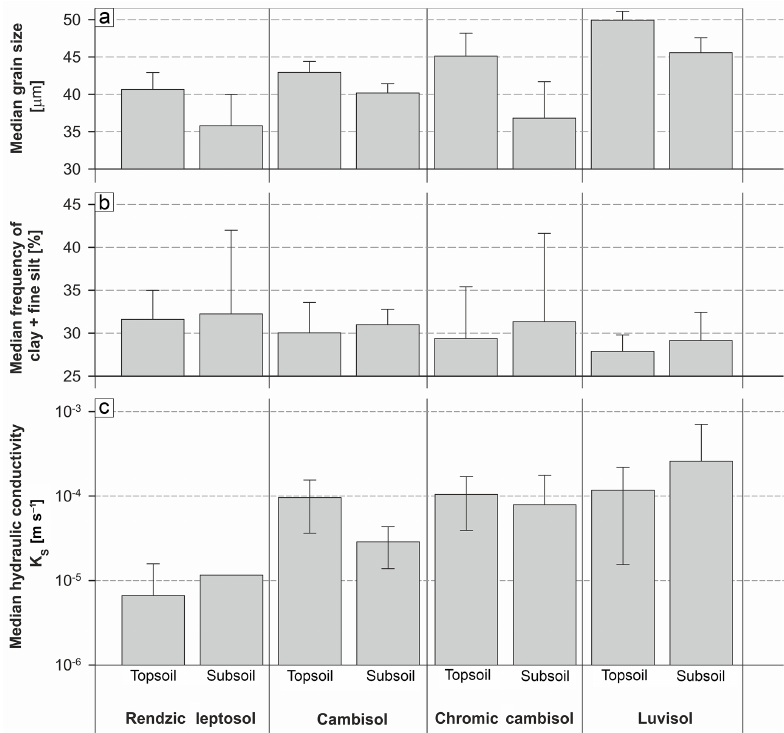
Figure 3. Physical properties of topsoils/subsoils and parent rocks of the four major soil groups. Median grain size decrease (a) and the frequencies of the fine grain size fractions (clay + fine silt) increase towards the subsoil (b) , respectively. (c) : median soil hydraulic con- ductivities of soil groups showing higher median soil hydraulic conductivity in Chromic Cambisols and Luvisols compared to the Rendzic Leptosols and Cambisols and general decreases in hydraulic conductivity towards the subsoil. The error bars describe the root of the estima- tion variance of the